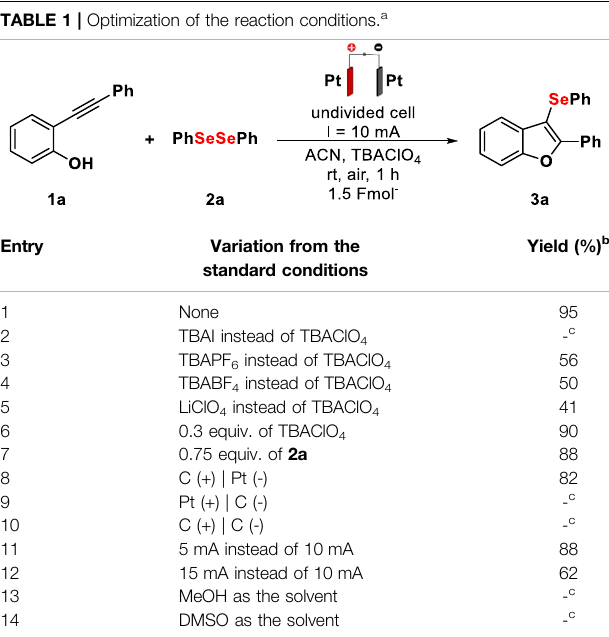
TABLE 1 | Optimization of the reaction conditions.